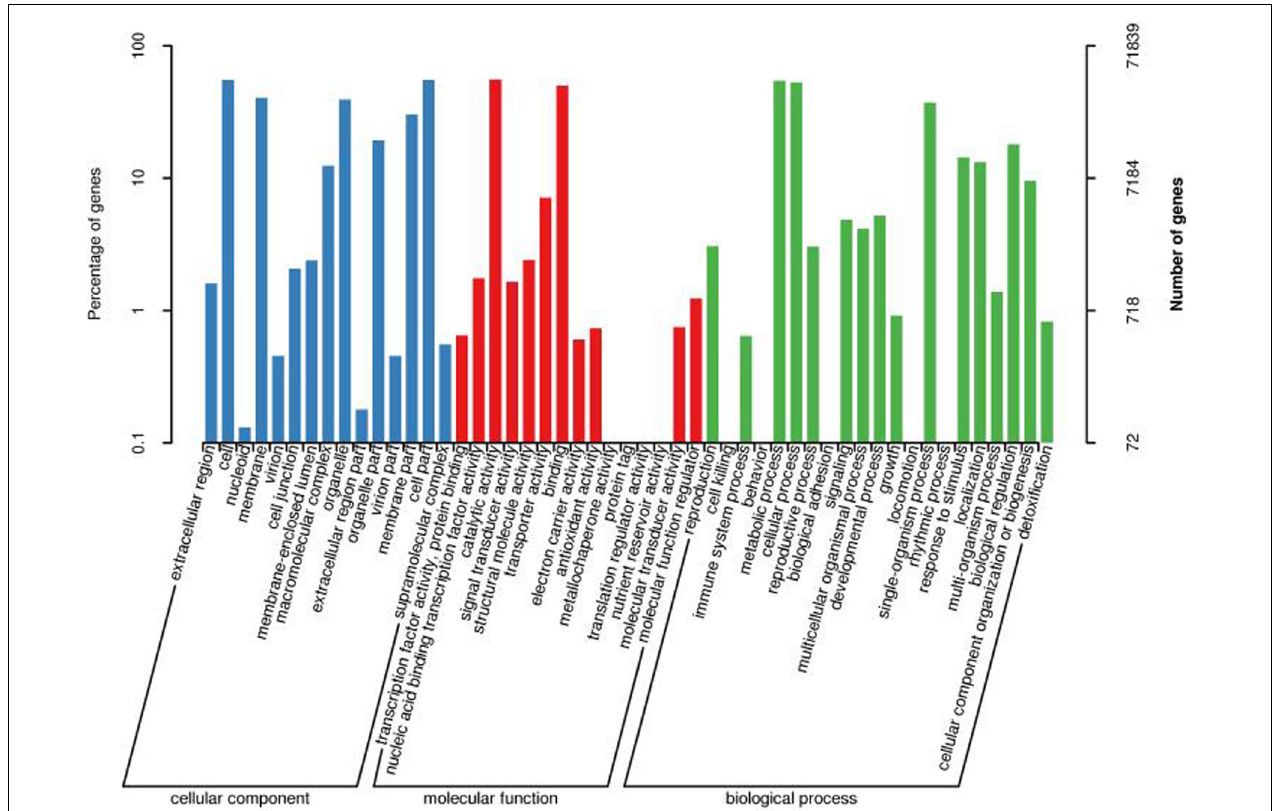
FIGURE 6 | Transcript GO annotation classification statistics